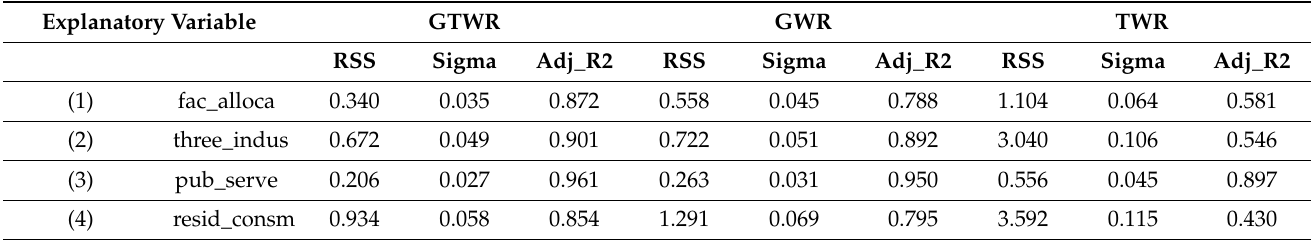
Table 5. Results of all kinds of weighted regression